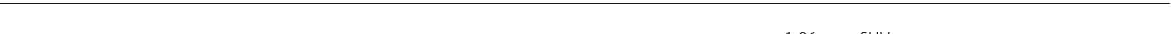
Fig. 6 Structure comparison of ternary and binary complexes. a Ribbon diagram of the ternary dU2A ′ – dSNF 1 – 96 – dU2 SLIV complex (green/steel blue/gold) superimposed on the binary dSNF 1 – 96 – dU1 SLII complex (gray/brown) according to the dSNF 1 – 96 subunits. The orientation of dSNF 1 – 96 is as in Fig. 1b. b Scheme of selected protein-RNA interactions in the dU2A ′ – dSNF 1 – 96 – dU2 SLIV complex. dSNF 1 – 101 and dU2 SLIV mutations and resulting relative binary af fi nities (assessed in the absence of dU2A ′ ) are indicated by arrows and labels. Because binding data had to be acquired at different salt concentrations to measure af fi nities accurately, the ratios of the dissociation constants of wild type and mutant dSNF 1 – 101 or dU2 SLIV are used to report changes. nx = K d (wt)/K d (mut). nx < 1 indicates wt af fi nity is higher; nx > 1 indicates mutant binds tighter. c Comparison of dSNF 1 – 96 contacts to the stems and regions around the loop-closing base pairs of dU2 SLIV (top panel) and of dU1 SLII (bottom panel). d Comparison of dSNF 1 – 96 contacts to the loops of dU2 SLIV (top panel) and of dU1 SLII (middle and bottom panel, representing two different complexes in the crystal structure with C14 contacting or turned away from dSNF 1 – 96 , respectively). Orientations relative to Fig. 1b are indicated by boxed rotation